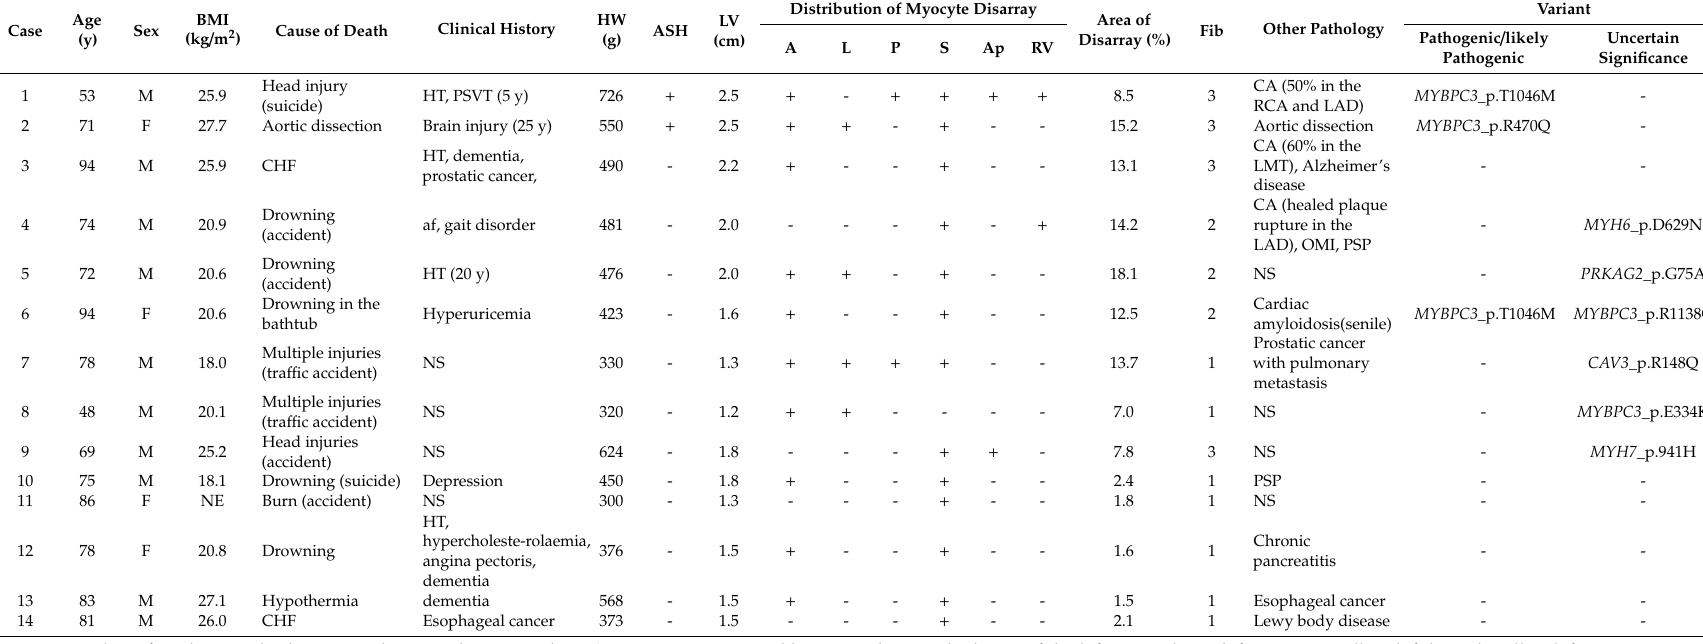
Table 1. Summary of clinical and autopsy